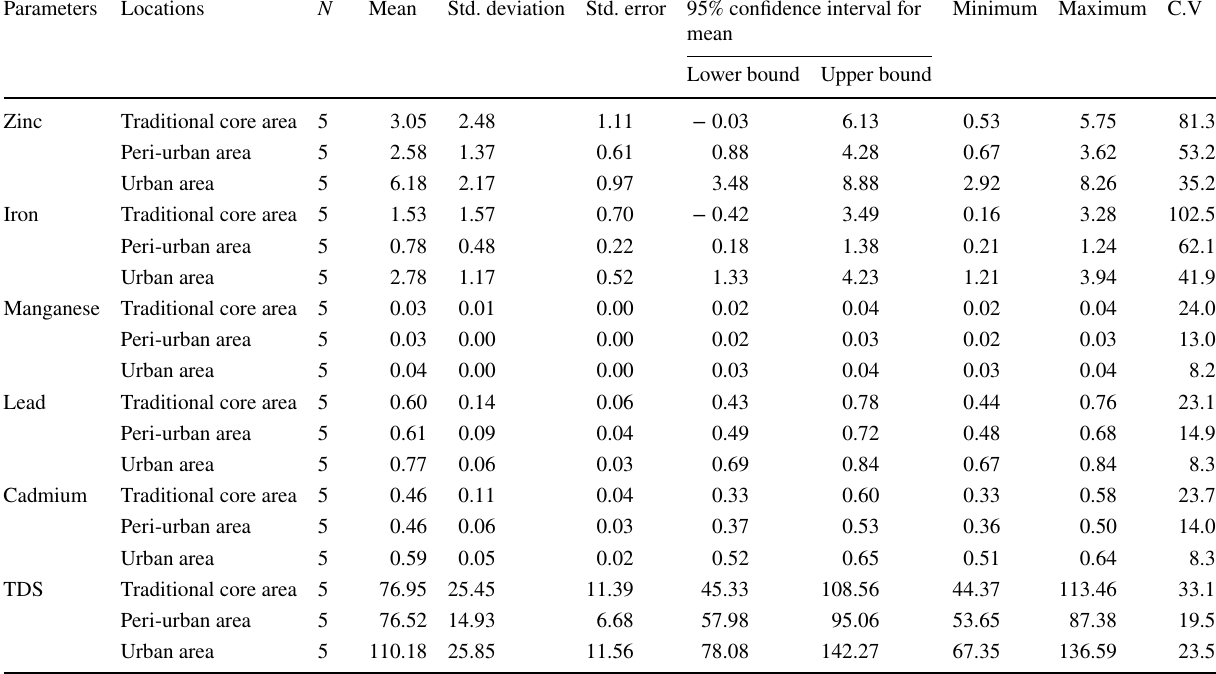
Table 4 Descriptive statistics of analyzed parameters in TCA, PUA, and UA of Ibadan metropolis Parameters Locations N Mean Std. deviation Std. error 95% confidence interval for